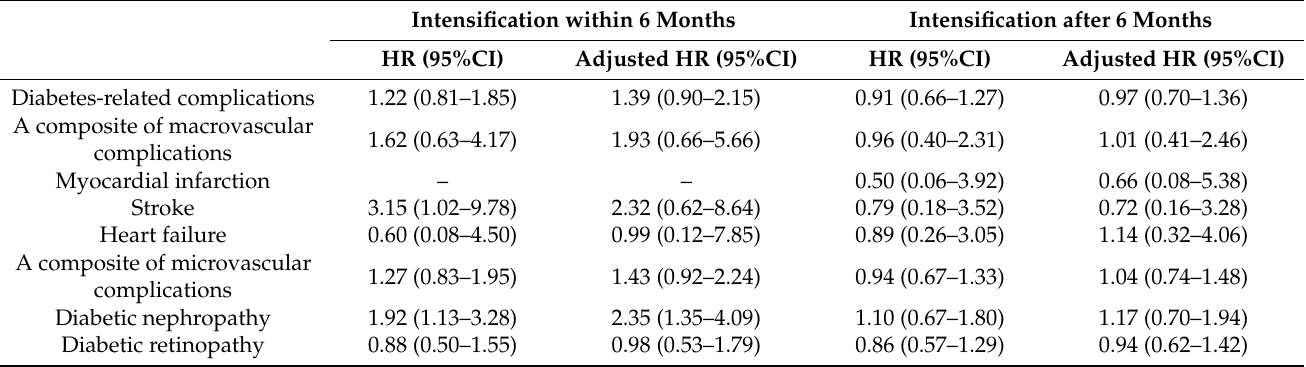
Table 3. Association between time to treatment intensification and diabetes-related complications.